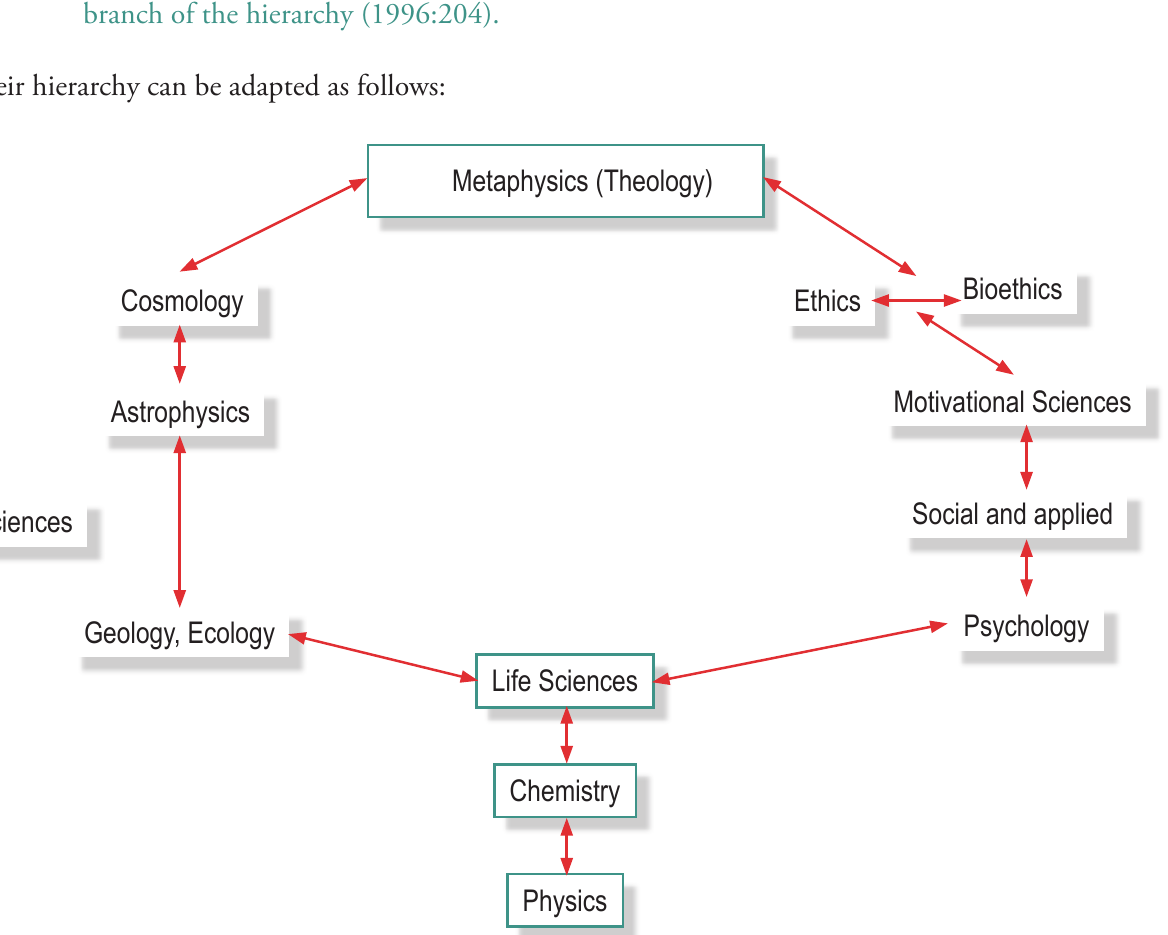
Fig 1 : Hierarchy of the sciences, and the place of bioethics